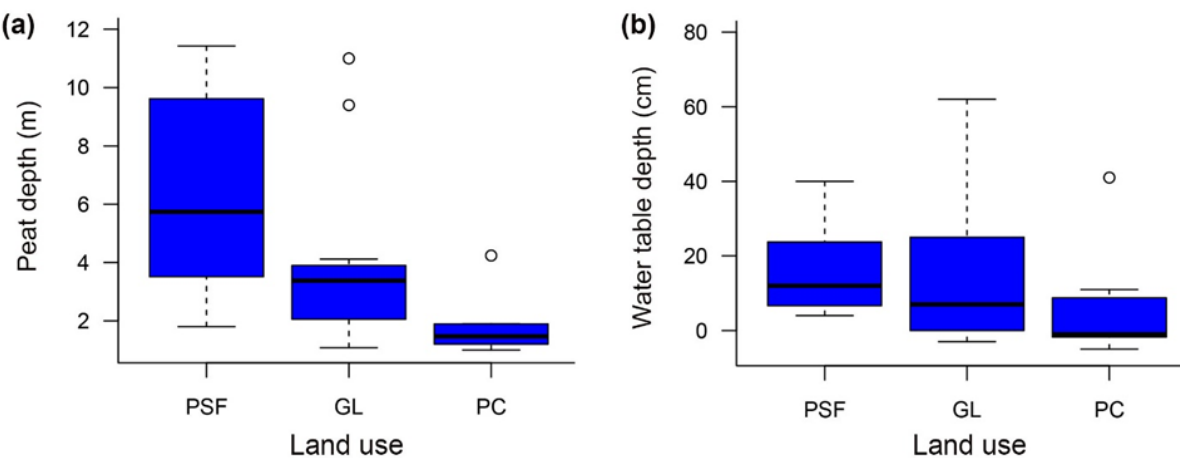
Figure 2. The measured (a) peat depth and (b) water table depth in the peat swamp forest (PSF), grassland (GL) and cultivation (PC) during the sampling period in the study area. The positive and negative values indicate that the water table is above and below the peat surface,